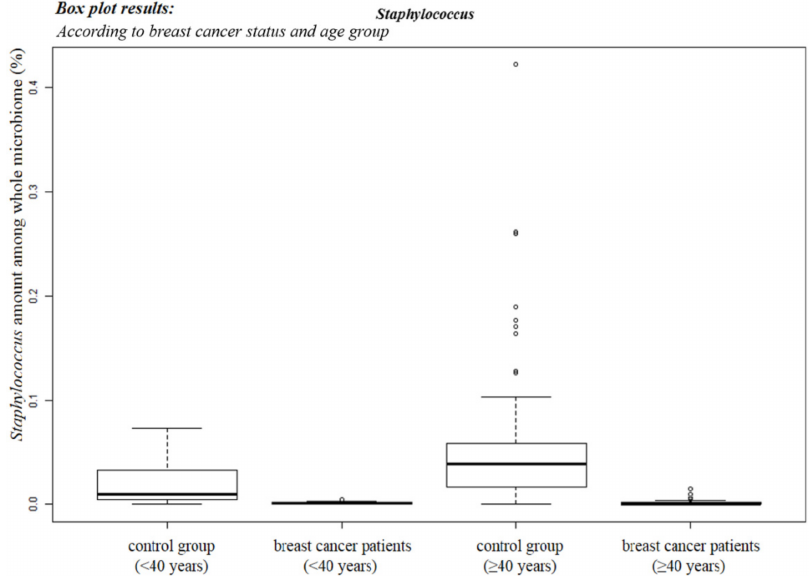
Figure 3. Average genus − level percentage of Staphylococcus in blood samples. The box plot shows the abundance ratio of Staphylococcus among the whole microbiota in both the healthy control group and breast cancer patients according to age. Error bars represent standard